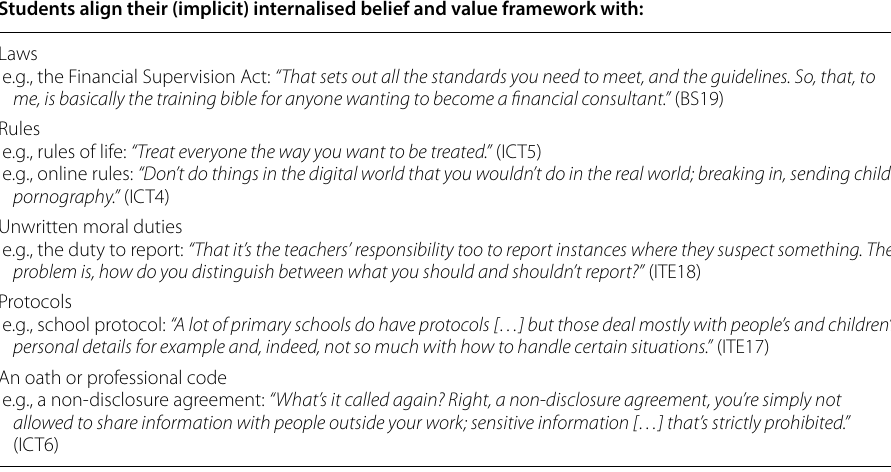
Table 1 Examples of students’ (external) moral guides Students align their (implicit) internalised belief and value framework with: Laws e.g., the Financial Supervision Act: “That sets out all the standards you need to meet, and the guidelines. So, that, to me, is basically the training bible for anyone wanting to become a financial consultant.” (BS19) Rules e.g., rules of life: “Treat everyone the way you want to be treated.” (ICT5) e.g., online rules: “Don’t do things in the digital world that you wouldn’t do in the real world; breaking in, sending child pornography.”